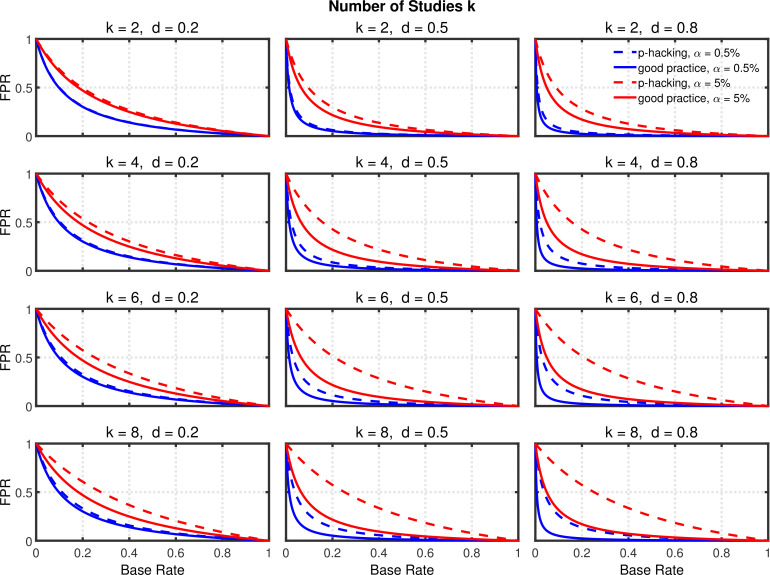
Selective reporting of significant studies.False positive rate (FPR) as a function of base rate π, number of studies k, effect size d, and nominal α level (0.5% or 5%). The nominal α level and power of the replication study are α2=5% and 1-β2=90%. All results are based on one-sample tests with n=20.